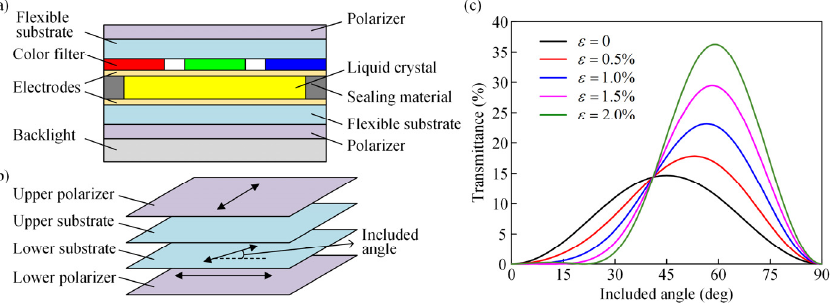
Figure 9. Guidance of flexible liquid crystal display applications by the anisotropy of the stress- optical properties. ( a ) Schematic diagram of the basic structure of a flexible liquid crystal display; ( b ) schematic diagram of the birefringence measurement of two flexible substrates; and ( c ) variation of the transmittance with the included angle under different strains.